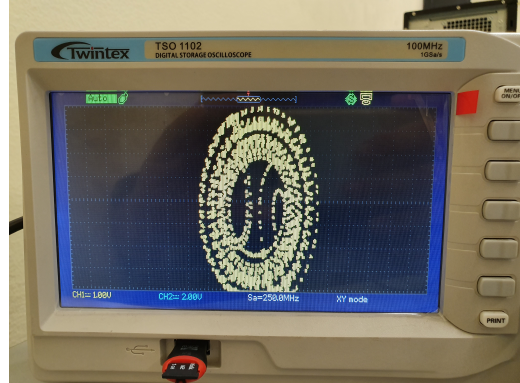
Figure 9. Acquired data from the slave system: ( a ) Projection on the plane ( x 1 , x 2 ). ( b ) Projection on the plane ( x 1 , x 3 ).